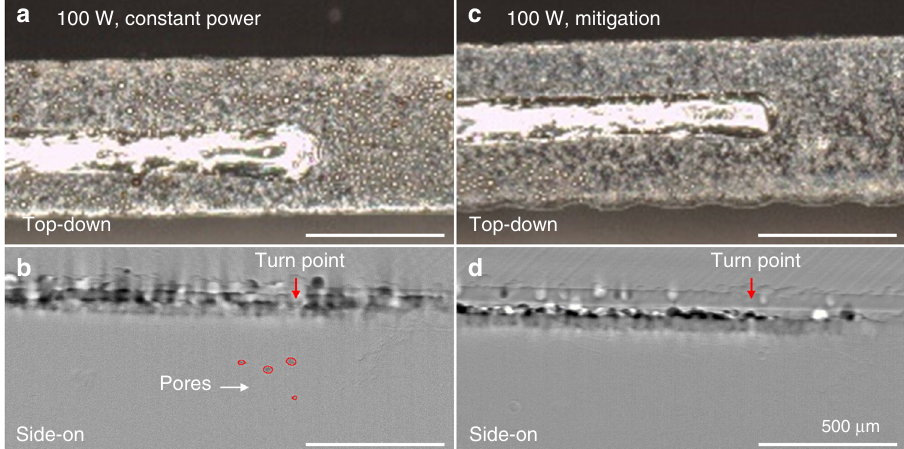
Fig. 7 Quality of LPBF-AM tracks in Ti – 6Al – 4V. a , b Top-down optical image and side-on X-ray image of a LPBF-AM track in the turn point region produced using a constant power of 100 W. Pores formed during LPBF are highlighted in b . c , d Top-down optical image and side-on X-ray image of an LPBF track produced using the 100 W peak power pore mitigation scan strategy shown in Fig. 5b. No pores were detected in d . All scale bars are 500 µ